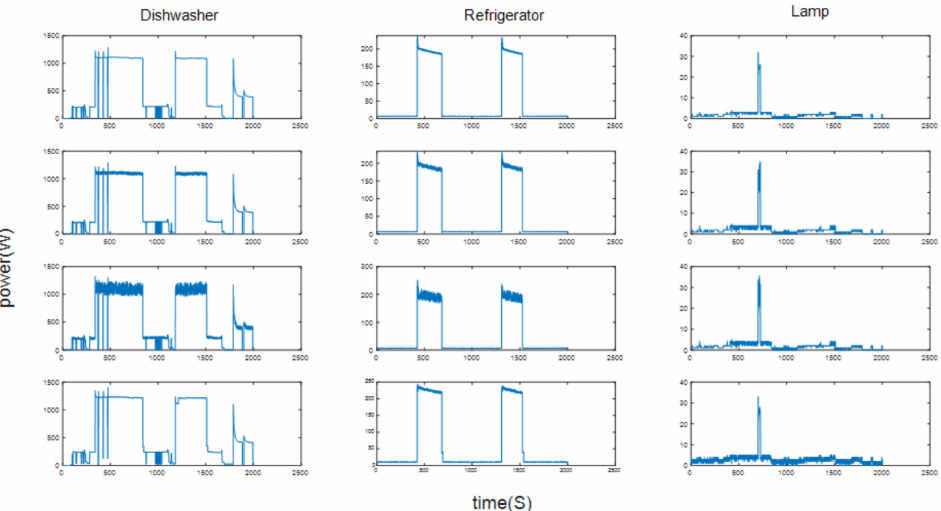
Figure 4. Identification results of three devices in home 1. (Line 1: the actual power curve of the load; Line 2: the load identification result based on the improved dAE algorithm; Line 3: the load identification result based on the standard dAE algorithm; Line 4: the load identification result based on the FHMM